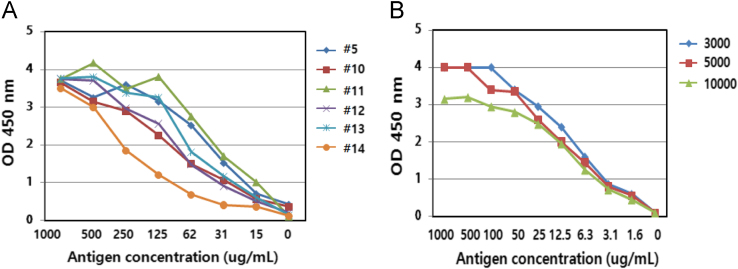
Indirect ELISA for testing the reactivity of antibodies. The reactivity of culture supernatants from selected hybridoma cells was checked by performing indirect ELISA according to the protocol described in Section 2.5. Six positive clones were selected based on testing the supernatants of the hybridoma cells.